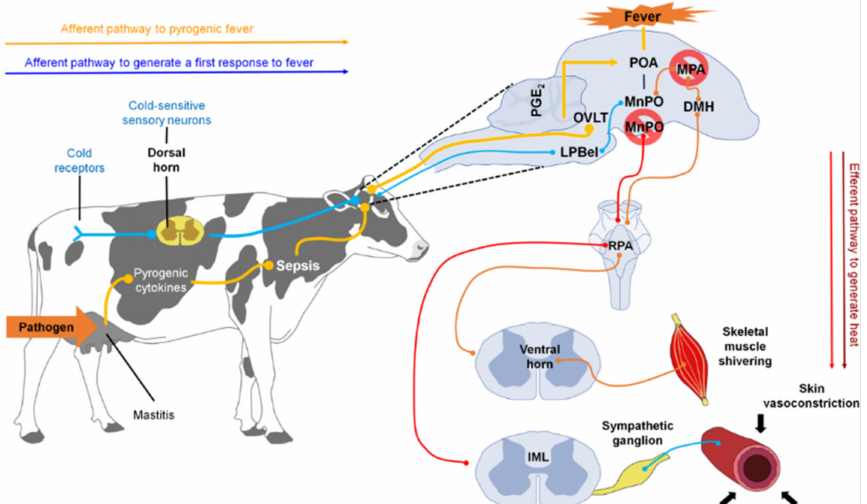
Figure 6. Neurophysiological mechanism for the development of a first physiological response to the development of fever in a cow. The febrile process is triggered by the entry of a pathogen into the body, which releases pyrogenic cytokines that, when interacting with the organum vasculosum of the lamina terminalis (OVLT), increases the synthesis of PGE2. This prostanoid acts at the POA level, causing the development of pyrexia. When the set point of the body temperature is elevated, thermoreceptors detect a low body temperature. They send a nerve impulse that reaches the lateral parabrachial nucleus of the lateral external subregion and is then projected to the median preoptic nucleus (MnPO). Once the information is received, the tremor response is developed by activating the thermogenesis-promoting neurons present in the dorsomedial hypothalamic nucleus (DMH) after inhibition of the medial preoptic area (MPA), which transmit an impulse that passes through the area of the raphe pallidus area (RPA) and the ventral horn of the spinal cord, up to the skeletal muscle. As well as peripheral vasoconstriction, through the activation of vasoconstrictor sympathetic premotor neurons present in the RPA, after inhibiting MnPO activity, which sends glutamatergic and serotonergic projections to the intermediolateral column (IML) to be transmitted to the sympathetic efferent fibers that innervate the cutaneous blood